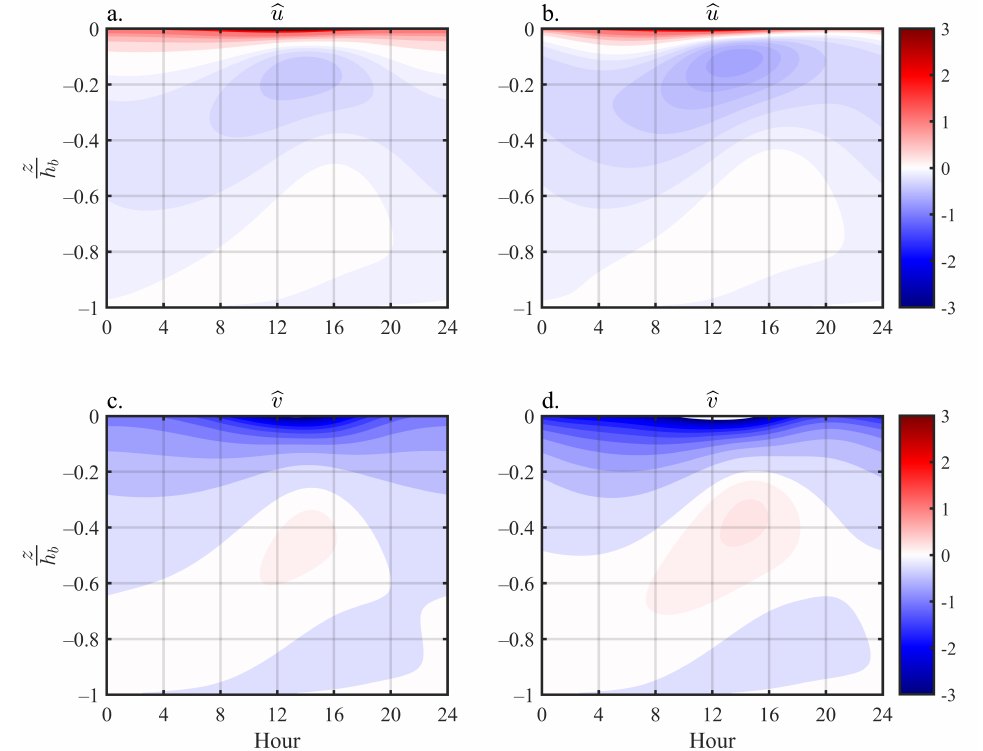
Figure 7. Diurnal evolution of zonal and meridional velocity without CSF ( a , c ) and with CSF ( b , d ) at a latitude of 45° N and δ = 0.6. All the velocities are normalized as in Figure 5. Contours are nonlinearly spaced to emphasize the deep variability.